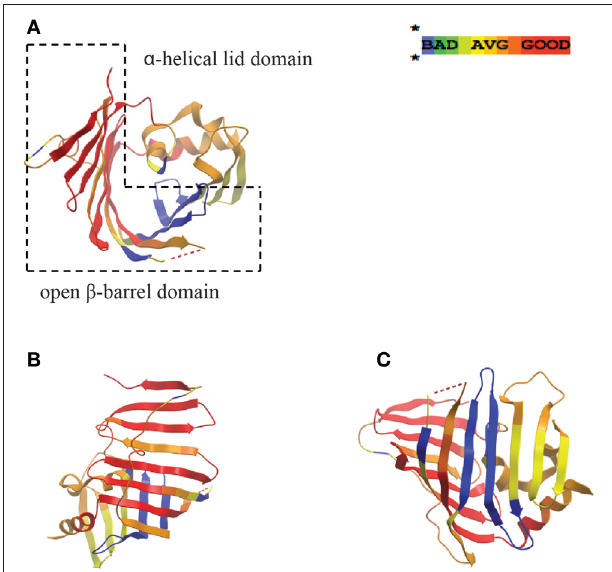
FIGURE 2 | LolA periplasmic lipoprotein chaperone from E. coli and H. pylori display structural homology at N-terminal region. Similarity protein alignments were constructed between E. coli and H. pylori LolA (HP0785) amino acid sequences and a “heat map” color scheme of protein homology based on similarity scores was generated. Crystal structures of E. coli LolA (PDB ID: 3KSN) were then used as a template for mapping the similarity scores. Red indicates very high confidence whereas green/blue indicate lower confidence in similarity comparisons. Views presented are an overhead of the putative, lipoprotein binding domain consisting of the open β -barrel with α helix lid (A) , the well-conserved, N-terminal β -sheet region (B) , and the less conserved, C-terminal β -sheet region (C) (the two β -strands missing in H. pylori LolA are indicated in blue). Protein sequence alignments and similarity scores were generated using T-Coffee analysis software (Poirot et al., 2003), the “heat map” CORE index for the alignment color gradient used algorithms described in the literature (Notredame and Abergel, 2003), and crystal structures were obtained from the Protein Data Bank (PDB) and viewed using ICM Brower Pro (MolSoft). The dotted red line in model represents an region in the amino acid protein sequence not present in the solved crystal